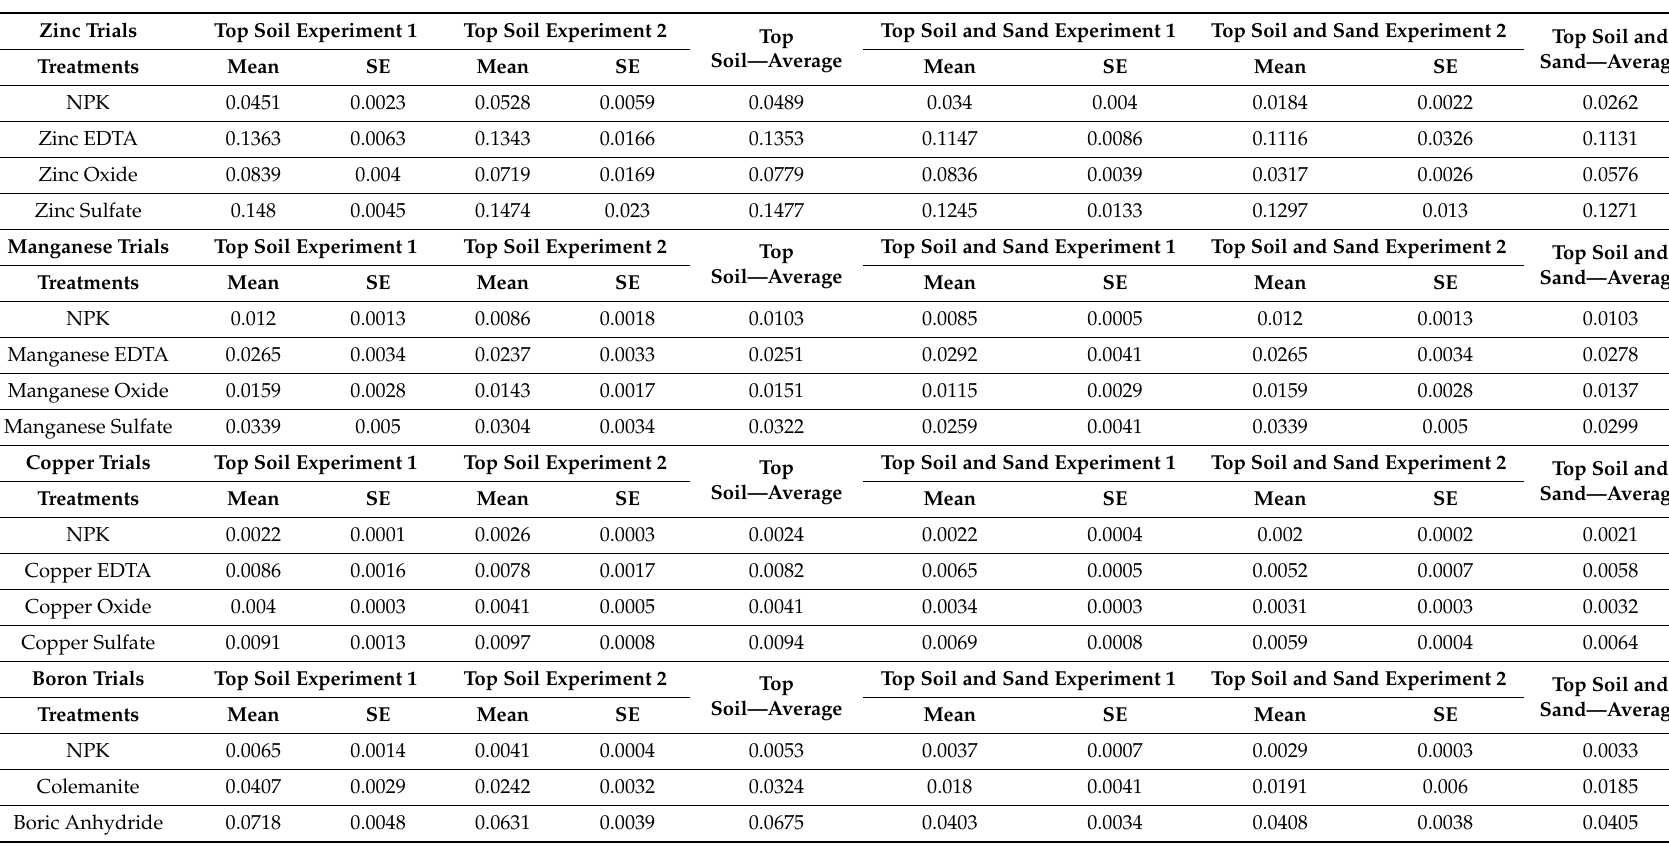
Table 2. Mean and standard error (SE) of, zinc, boron, manganese and copper, uptake for the two experiments in top soil and top soil and sand. All units for Mean and SE are in milligrams (mg). The average mean values were used to calculate percentage di ff erences. Percentage Di ff erence (%) = (Mean 2 − Mean 1) × 100 / Mean